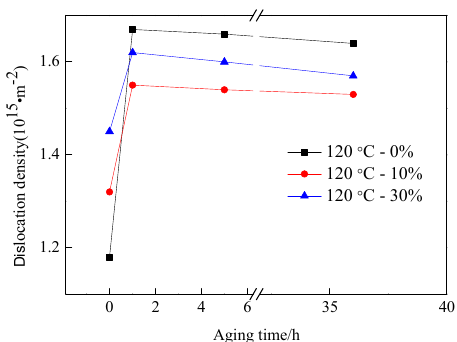
Figure 12. Dislocation density of the as-quenched and deformed martensitic steel with subsequent aging at 120 °C for various time periods.